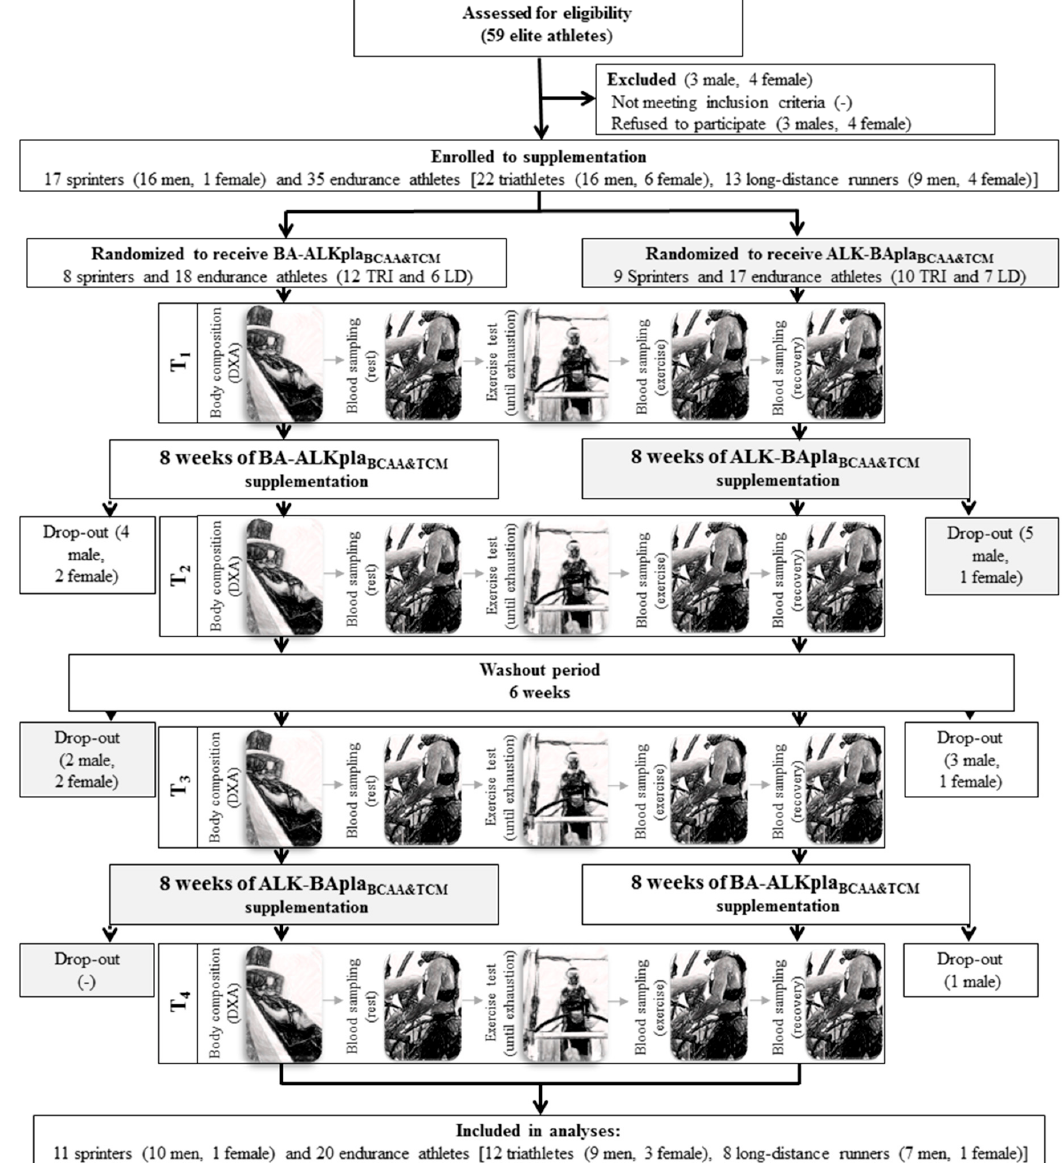
Figure 1. The flow chart of the study design. Abbreviations: ALK—Alkaline agents, BA—Beta- Alanine Carno Rush, BCAA—branched-chain amino acids, DXA—Dual X-ray Absorptiometry, LD— long-distance runners, pla—placebo, TCM—creatine malate, and TRI—triathletes.